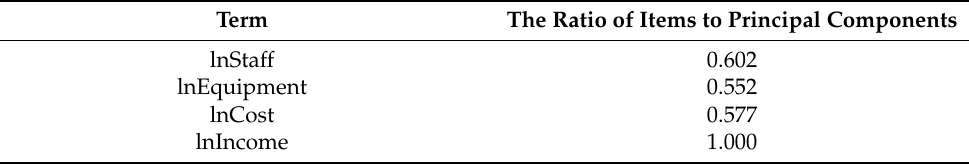
Table 4. Mathematical relationship between principal components and research items. Term The Ratio of Items to Principal Components